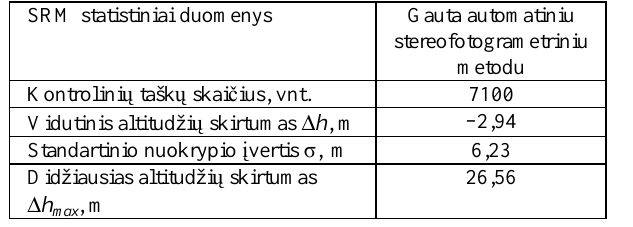
Table 4. Statistical accuracy parameters of DTM